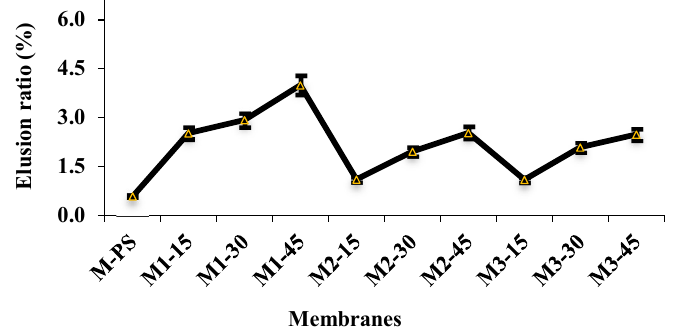
Figure 7. Elusion ratio of all formulated membranes (n = 5).